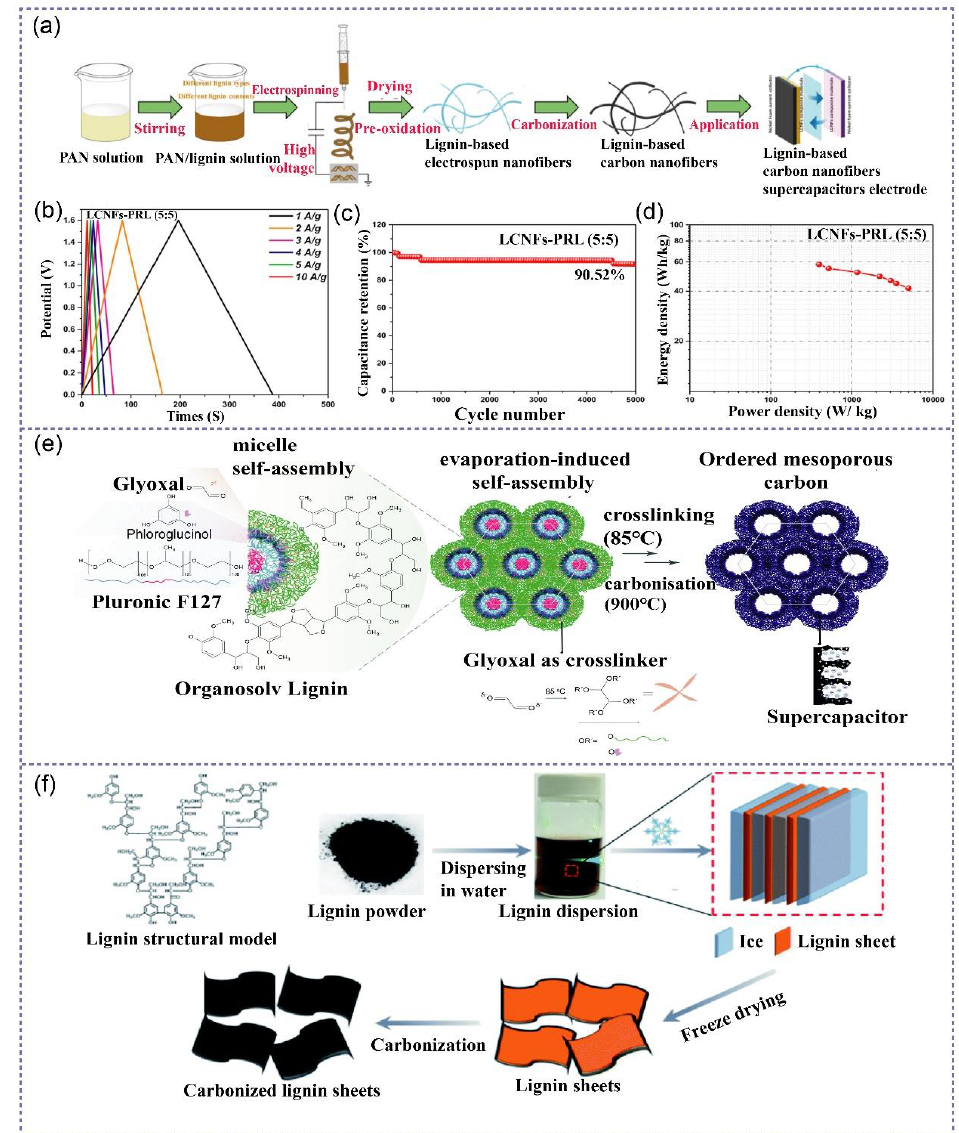
Figure 5. ( a ) The formation process of lignin-based carbon nanofibers. ( b ) GCD curves of LCNFs-PRL (5:5) at different current densities from 1 to 10 A/g. ( c ) Capacitance retention and the cycle number and ( d ) Ragone plots of symmetric supercapacitors. ( e ) Schematic diagram of the preparation of ordered mesoporous carbon. ( f ) The preparation process of carbonized lignin sheets (From Refs. [79,80,82]).